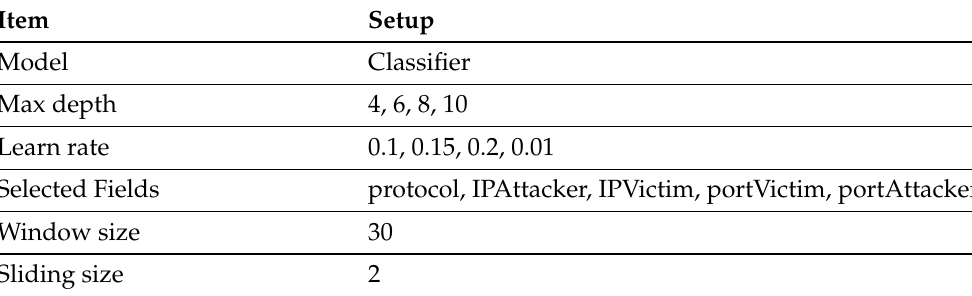
Table 1. XGBoost